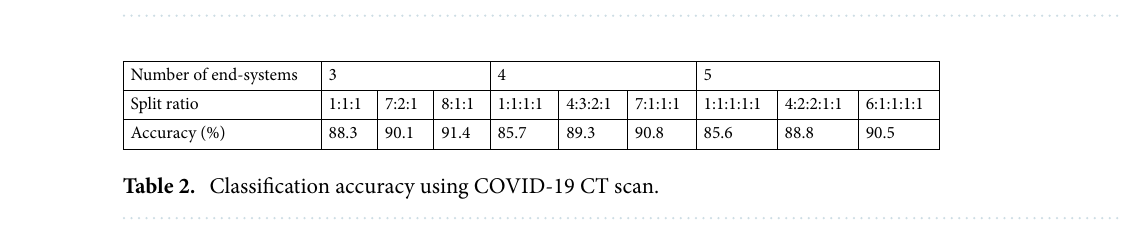
Figure 6. Performance tested with five end-systems. The graph depicts the classification results with four end- systems having 1:1:1:1:1, 4:2:2:1:1 and 6:1:1:1:1 data-imbalance.